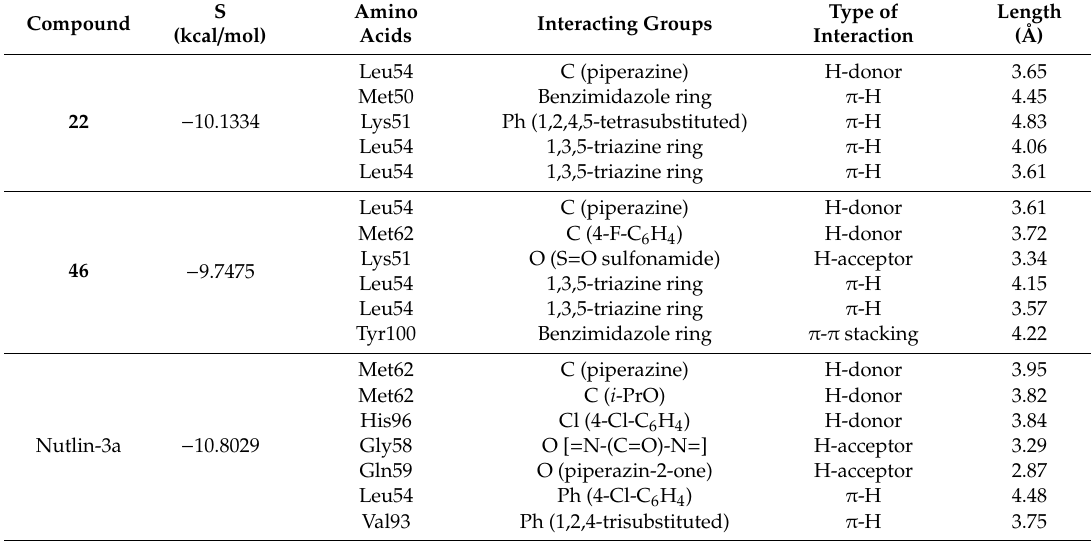
Table 3. Docking results of the most active compounds 22 , 46 with MDM2 protein (PDB ID:5C5A). S Compound (kcal /